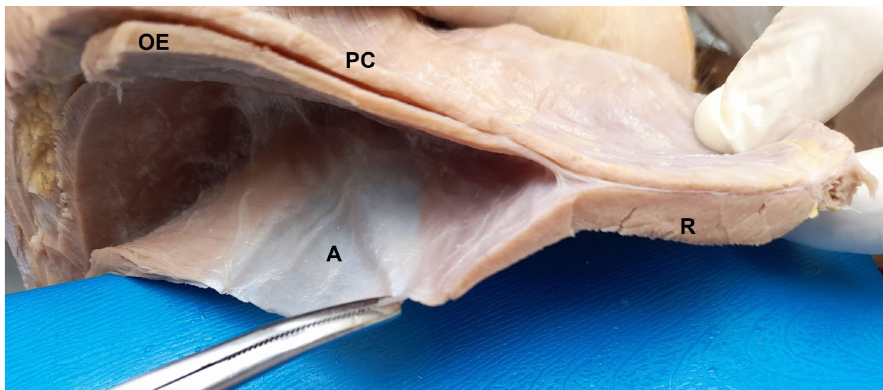
Figure 5. PC: cutaneous muscle; OE: external abdominal oblique muscle; OI: internal abdominal oblique muscle; A: aponeurosis of OI recovering R: rectus abdominis muscle.